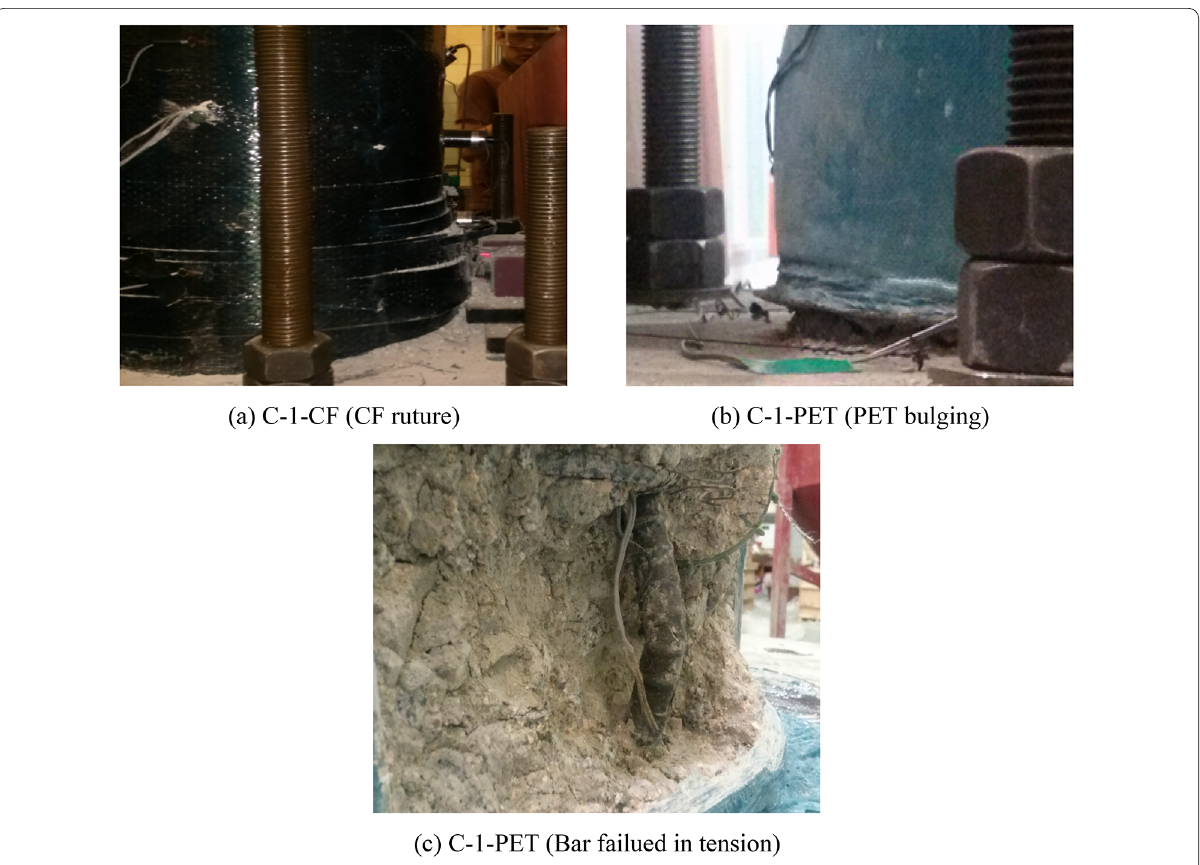
Fig. 8 Failure mode of CF and PET‑strengthened TG‑1